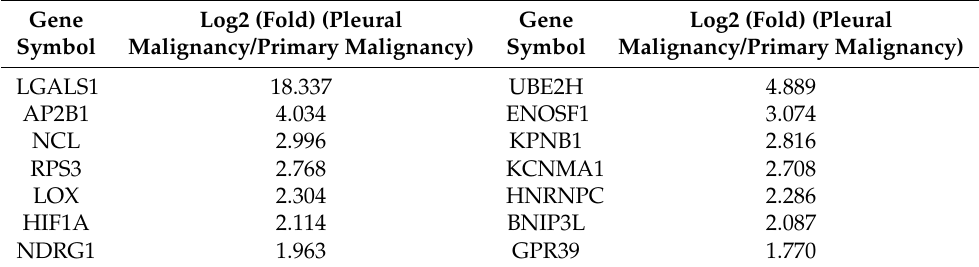
Figure 1. Identification of ubiquitin conjugating enzyme E2 H (UBE2H) from lung adenocarcinoma (LUAD) tumor samples. ( A ) The volcano plot (log2 fold-change vs. log10 p -value) of upregulated and downregulated genes showed the differential expression distribution for the sample pair. The green and red dots indicate significant down- and up-regulated genes, respectively. ( B ) The enriched biological processes by gene set enrichment analysis. ( C ) The histogram plot of hypoxia- related gene set. ( D ) The correlation of UBE2H with the genes of the hypoxic pathway. ( E ) The expression of UBE2H in the samples collected in the present study. ( F ) The expression of UBE2H in the lung adenocarcinoma (LUAD) samples of the Cancer Genome Atlas (TCGA). NES-normalized enrichment score; FDR-false discovery rate; FPKM-fragments per kilobase of transcript per million. Table 1. The expression of the specific genes in the hypoxia-related gene